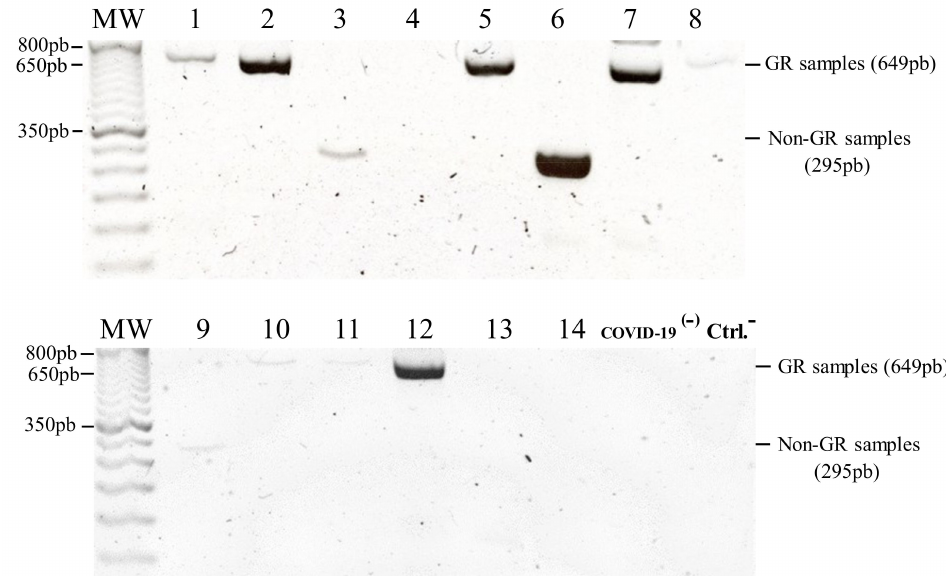
Figure 3. Agarose gels showing the electrophoresis of the ARMS assay products. The bands corre- sponding to molecules of 649 bp indicate the presence of GR clade samples whereas bands of 295 bp indicate non-GR samples. Note that samples 4, 13 and 14 did not yield a distinguishable product. (MW, molecular weight marker; 1-14, SARS-CoV-2 positive samples; COVID-19 ( − ) , SARS-CoV-2 neg- ative saliva RNA sample; Ctrl − , Negative, no-cDNA control). Table 3. Clade GR or non-GR classification of the SARS-CoV-2 positive samples (SPL), according to the SA-HRM and ARMS assays.